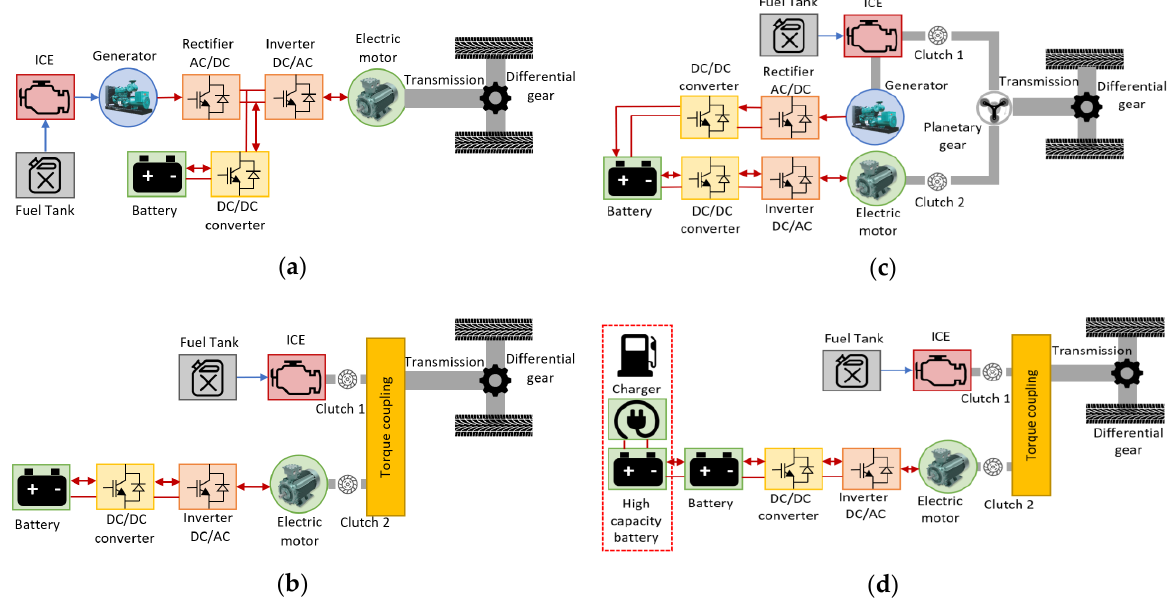
Figure 11. Simplified electrical diagrams of different traction drive configurations in HEV adapted from [44]: ( a ) ICE-based series; ( b ) ICE-based parallel; ( c ) ICE-based series-parallel; ( d ) ICE-based plug-in.